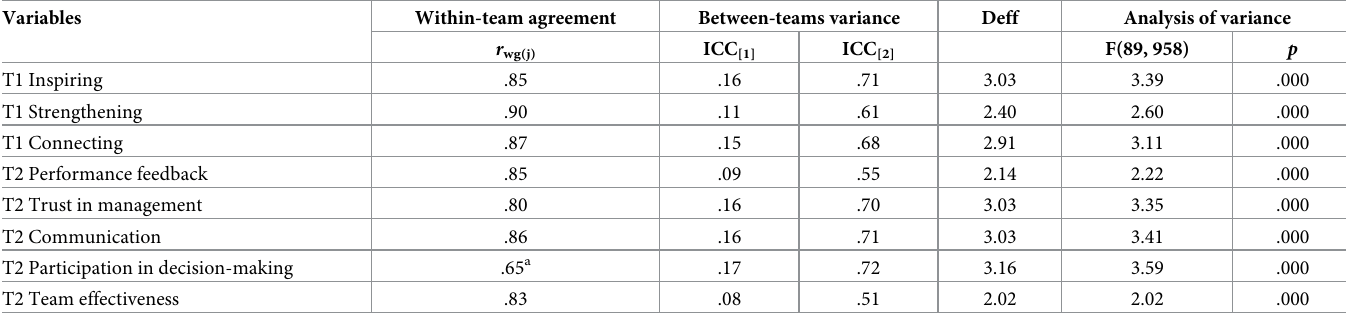
Table 1. Aggregation test results for team level